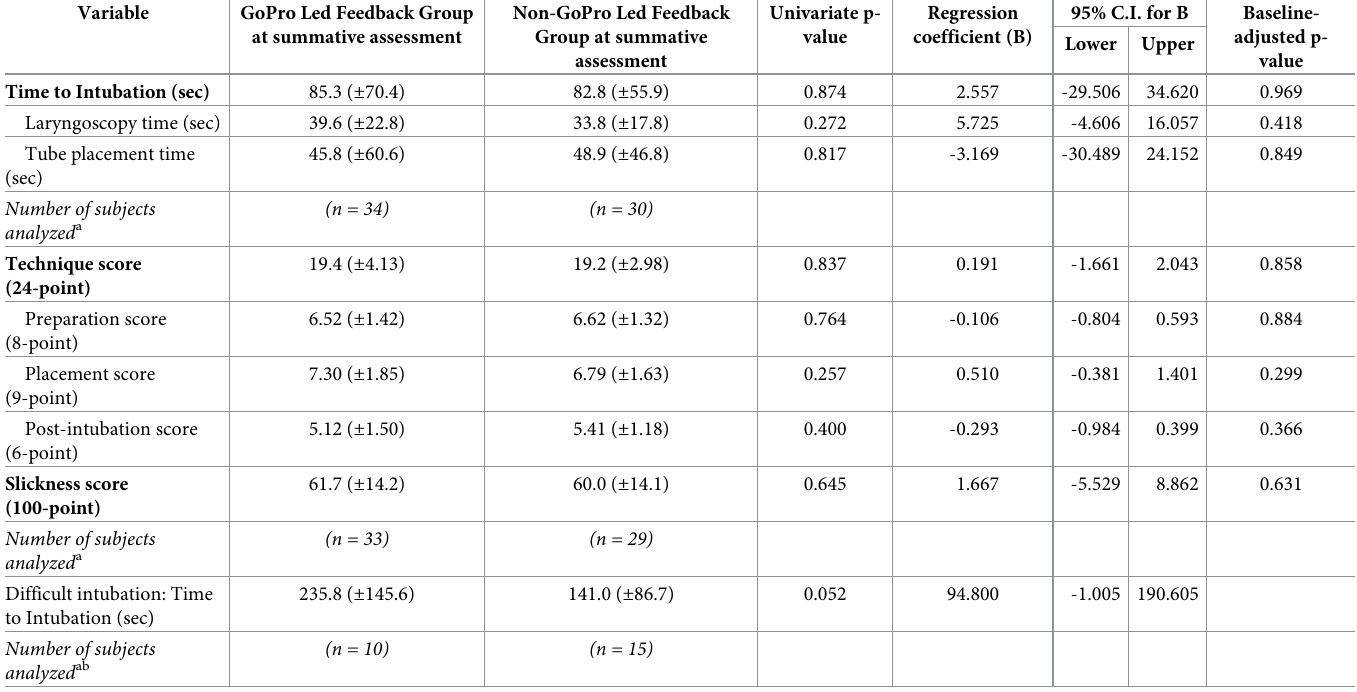
Compared to the Laerdal 1 Airway Management Trainer, most participants were not able to intubate the Difficult Airway Management Simulator. No statistically significant differences were found between the GoPro group and the non-GoPro group in terms of all 3 exploratory outcomes. Table 3. Continuous outcomes at summative assessment with univariate and baseline-adjusted analysis.